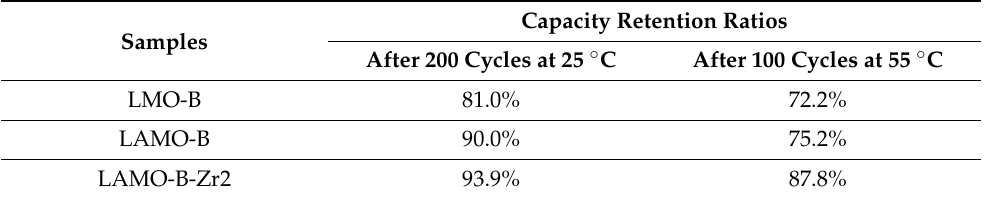
Table 2. The capacity retention ratios of LMO-B, LAMO-B, and LAMO-B-Zr2. Samples